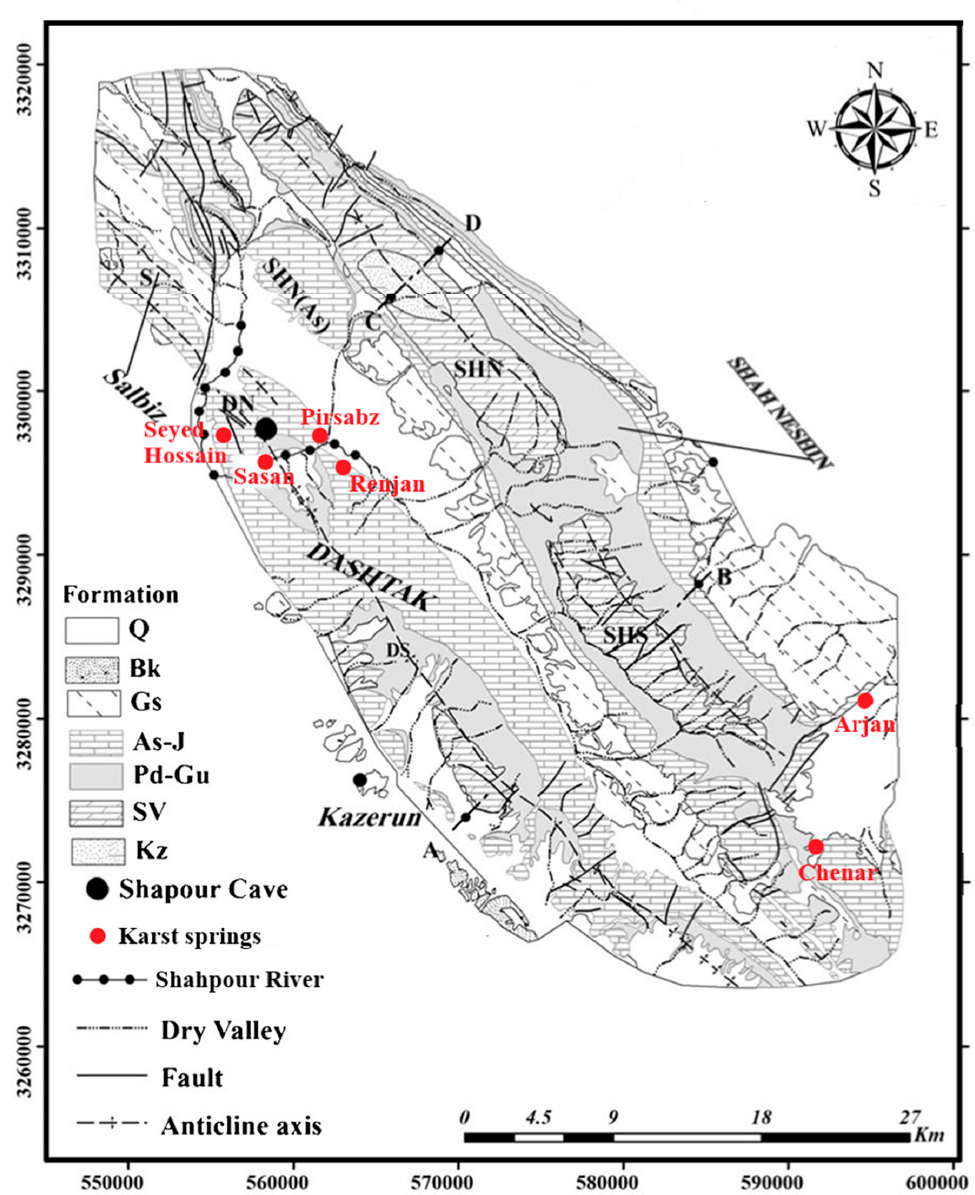
Figure 2. Karst aquifers in the Kazeroon County (Northern Dashtak (DN), Southern Dashtak (DS), Northern Shahneshin (ShN), Northern Asmari Shahneshin (ShS(As)), Southern Shahneshin (ShS), and Salbiz (S) modified from [28].